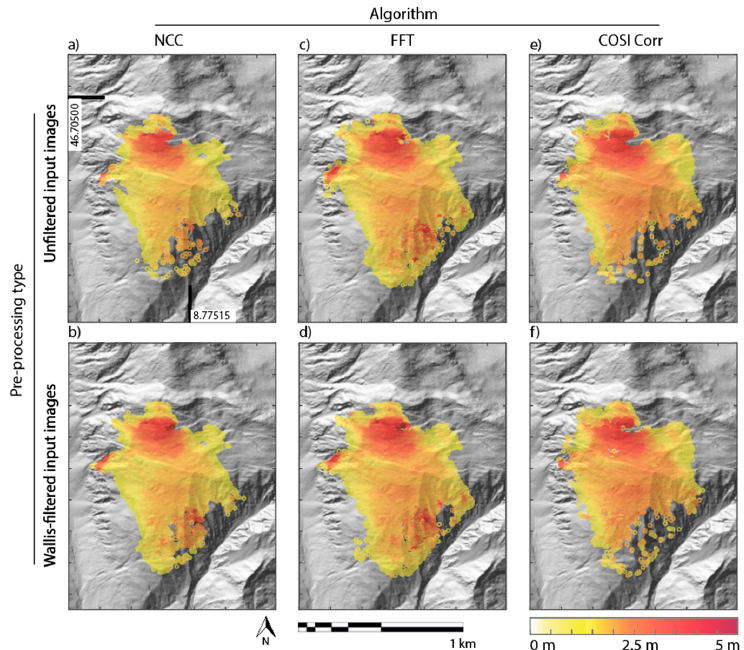
Figure 3. CdV displacement field returned from the normalized cross correlation (NCC)-based code ( left column ), the fast Fourier transformation (FFT)-based code ( center ), and COSI Corr ( right ); top row is based on original input imagery, the bottom row is based on Wallis-filtered data. Blank areas indicate portions of the slope with displacements below DIC accuracy or without information. All runs were performed with a scan window size of 64 × 64 pixels and a spatial vector filter. WGS 84. (Hillshade taken from [40].)